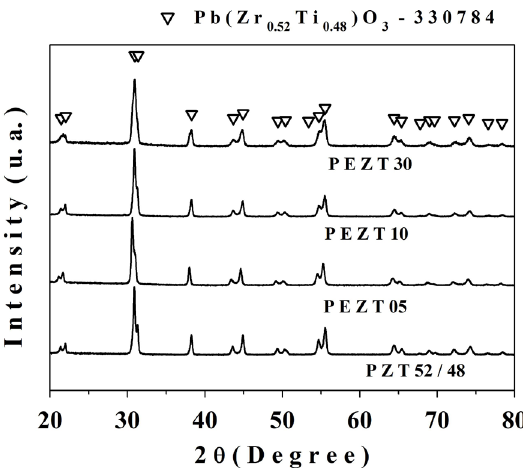
Figure 2. XRD patterns of sintered ceramics (all compositions).